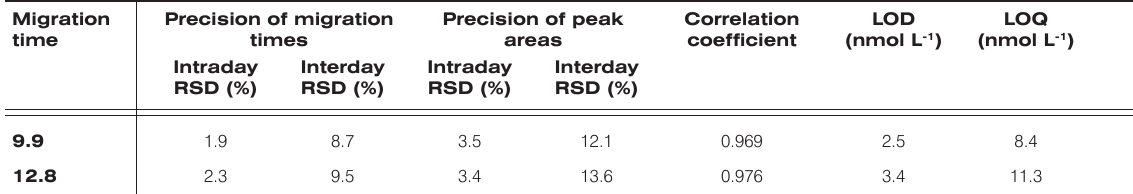
Table 1. Partial validation results for both ketoprofen enantiomers*. Migration